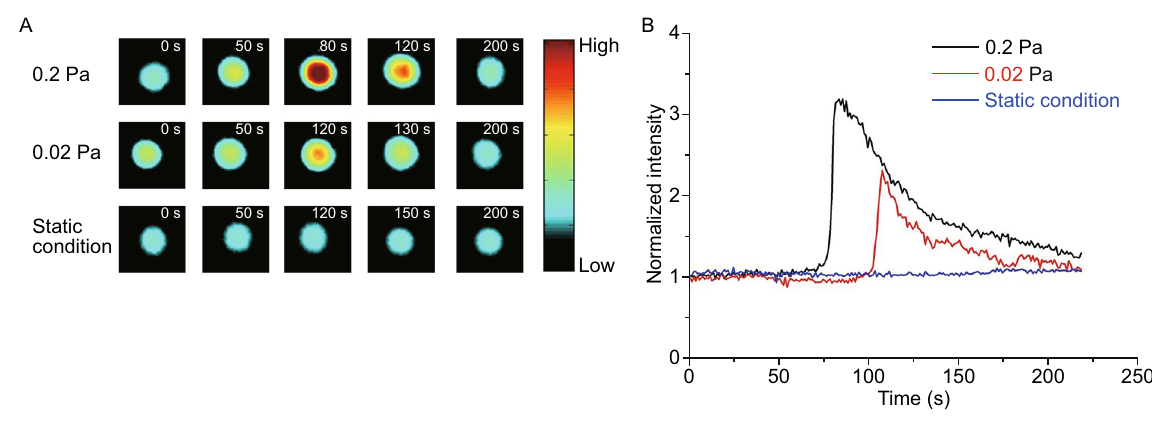
Figure 2. Calcium bursting of fi rmly adhered neutrophils on P-selectin in fl ow. (A) Three series of typical fl uorescence images of fi rmly adhered neutrophils on immobilized P-selectin at different times, and (B) the time-course of the normalized fl uorescence intensity of the cells over the observation time. Here, blue, red, and black represent the time courses performed with wall shear stresses of 0.0, 0.02, and 0.2 Pa on